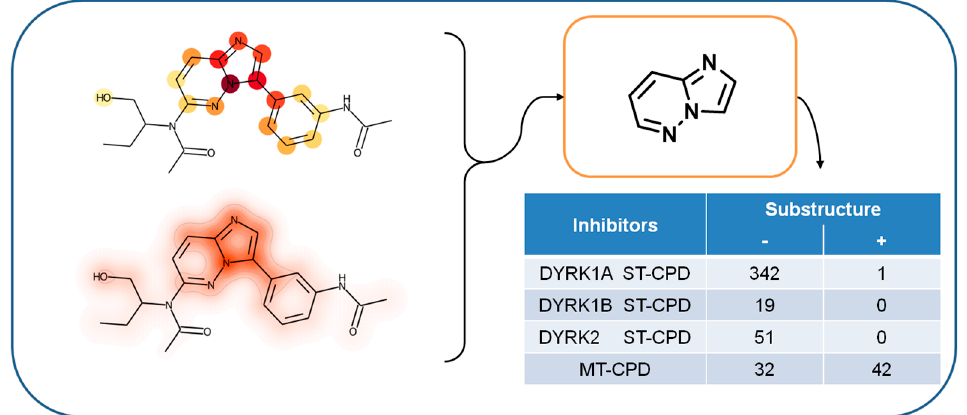
Figure 5. Feature mapping for MT-CPDs of triplet 2. The presentation is according to Figure 4. In the molecular representation on the upper left, the continuous atom color code indicates the number of extracted features per atom, ranging from 1 (yellow) to 11 (brown). Both molecular representations identify the imidazo(1,2-b)pyridazine substructure (upper right) as the center of positive feature contributions to the correct prediction of this MT-CPD and others containing this substructure. The presence (+) or absence ( − ) of the substructure in ST- and MT-CPDs of triplet 1 is reported in the table insert (lower right).